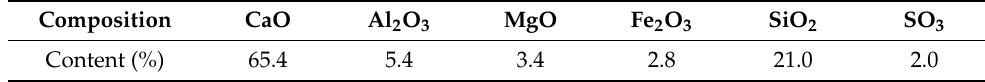
Table 1. Chemical composition of cement.